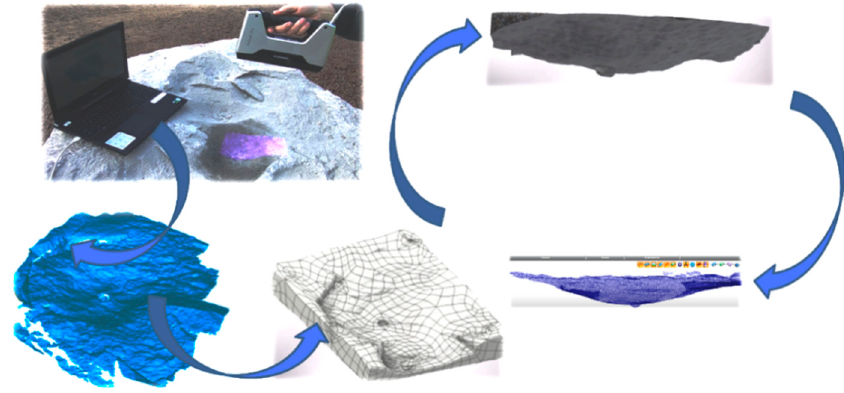
Figure 12. The failure cone modelling procedure.